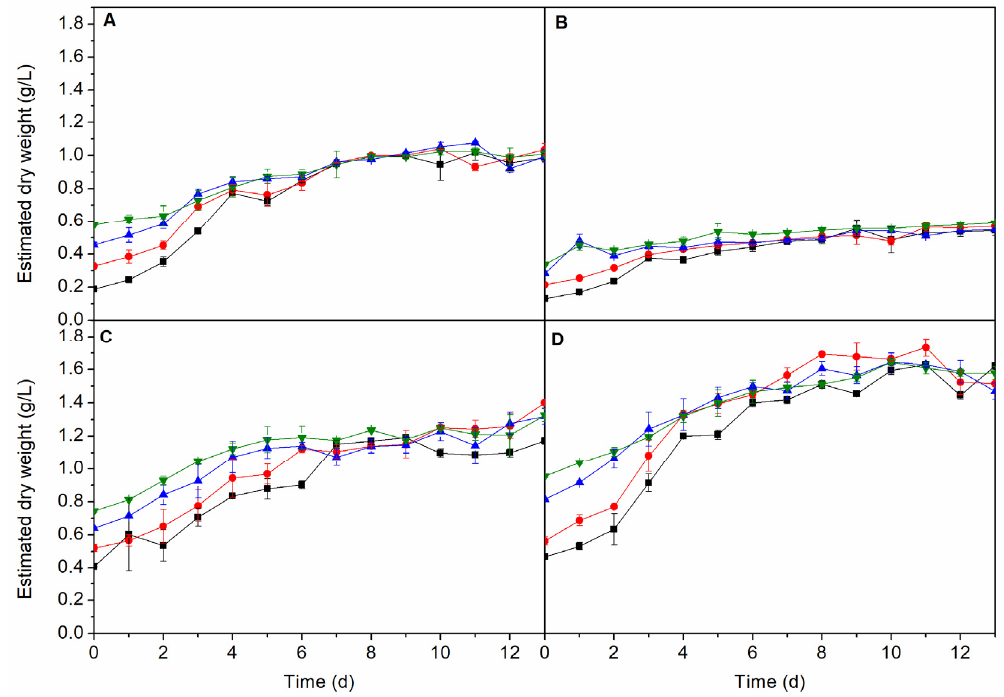
Figure 1. Growth of A. maxima ( A ), C. vulgaris ( B ), I. galbana ( C ) and N. gaditana ( D ) at di ff